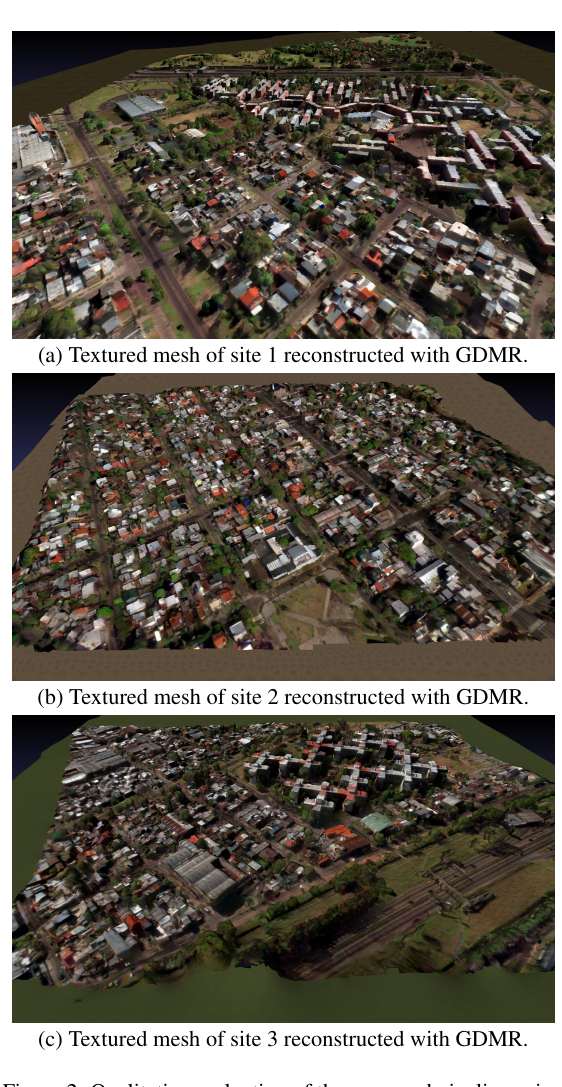
Figure 2. Qualitative evaluation of the proposed pipeline using Figure 3. Qualitative evaluation of our pipeline using multi-date using GDMR (Ummenhofer and Brox, 2017) for three sites satellite images by Bosch et al. (2016). We observe that Poisson contained in the multi-date satellite image dataset provided by (Kazhdan and Hoppe, 2013), Colmap (Sch¨onberger et al., 2016) Bosch et al. (2016). and GDMR (Ummenhofer and Brox, 2017) reconstruct meshes with different shape